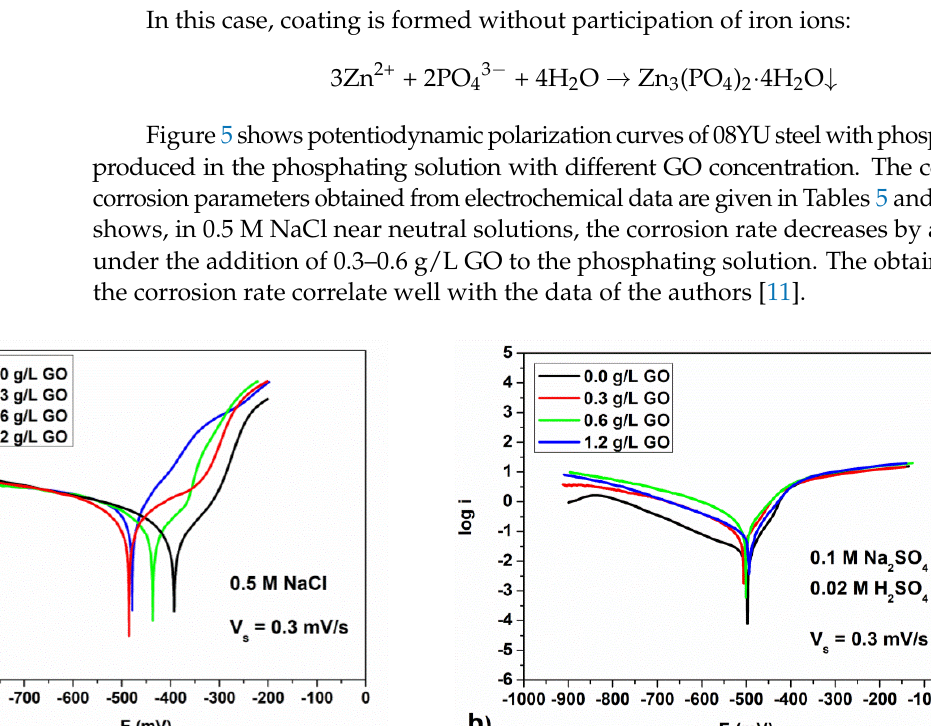
Table 4. Phase composition of the phosphate coatings.